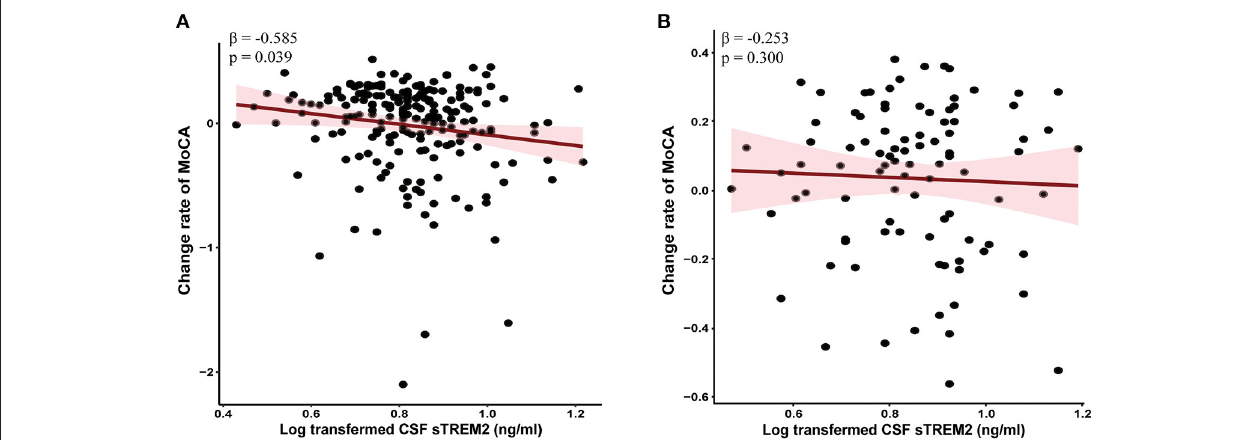
FIGURE 3 | Higher baseline CSF sTREM2 had faster global cognitive declines in PD group (A) but not HC group (B) . The normalized regression coefficients ( β ) and p -values computed by mixed-effect linear models after adjustment for age, gender, educational level, and APOE ε 4 carrier status. CSF, cerebrospinal fluid; sTREM2, soluble triggering receptors expressed on myeloid cells 2; HCs, healthy controls; PD, Parkinson’s disease. TABLE 2 | Progression risk from normal cognition to MCI or from MCI to dementia. Lowest tertile Middle tertile Highest tertile HR (95%CI) p HR (95%CI)